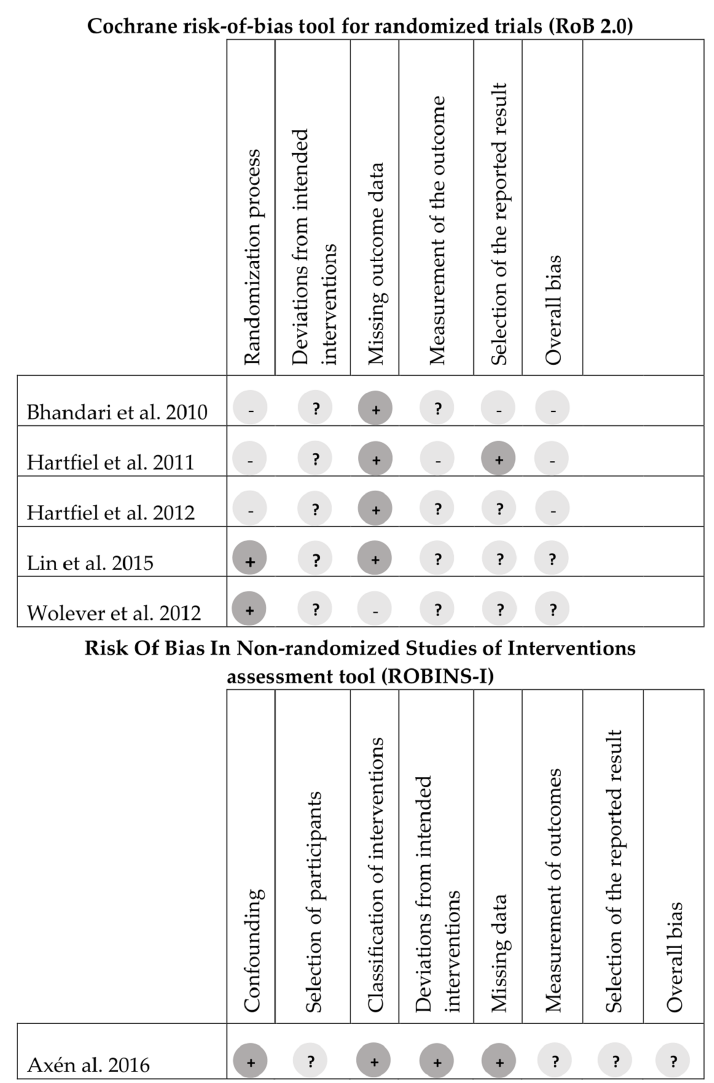
Figure 3. The assessment of the risk of bias of included studies. Note: “ + ” = low risk, “ − “ = high risk, “?” = some concerns.